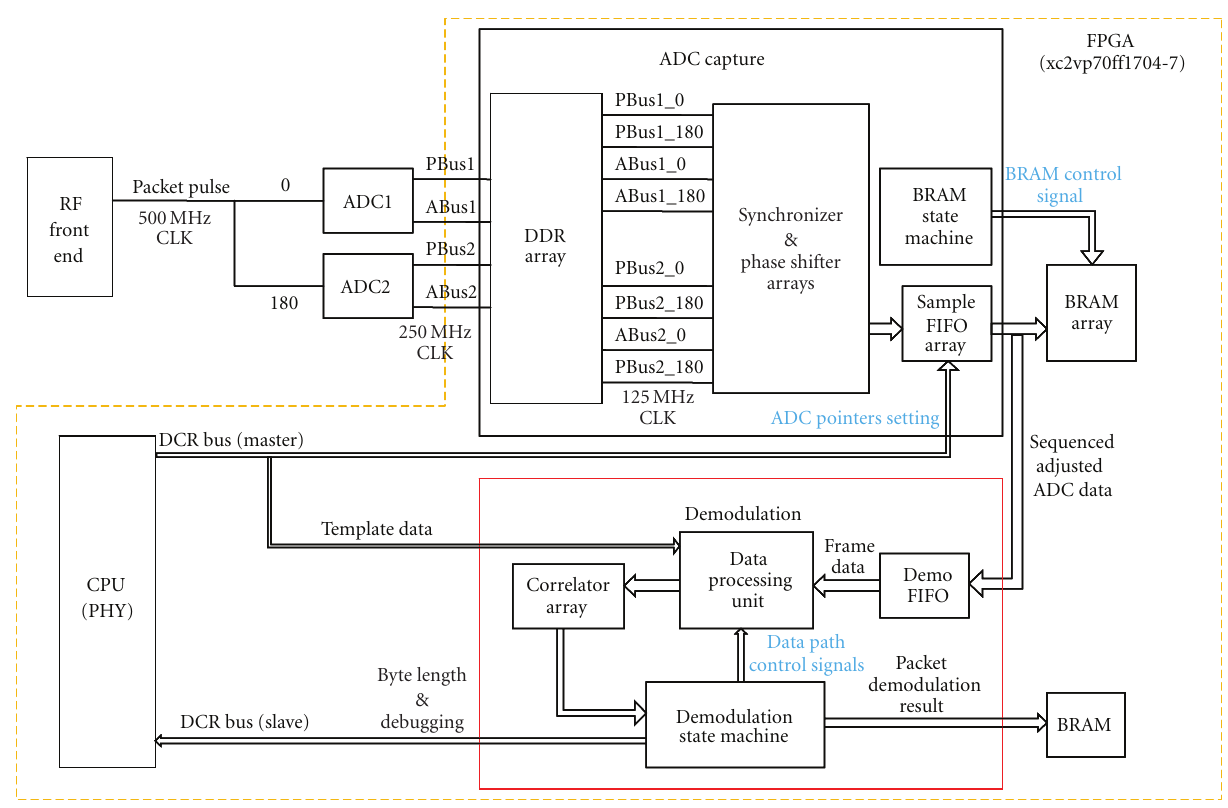
Figure 6: Receiver hardware blocks.